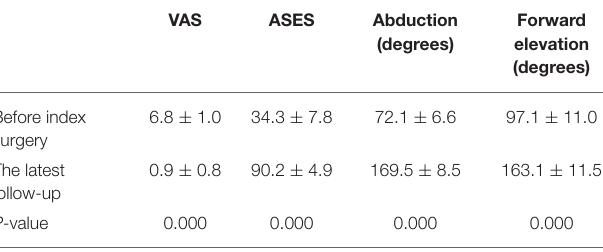
TABLE 2 | Clinical outcomes at the two time points during